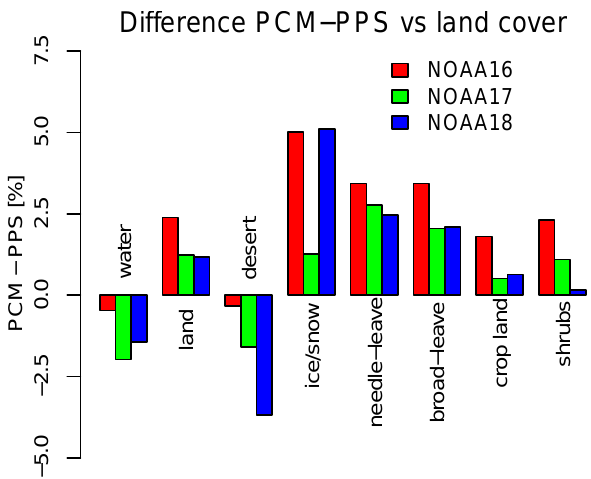
Fig. 8. Total cloud cover differences PCM–PPS as a function of land cover derived from the annual pixel counts for the years 2011 (NOAA16) and 2008 (NOAA17 and 18). For details see Sect.